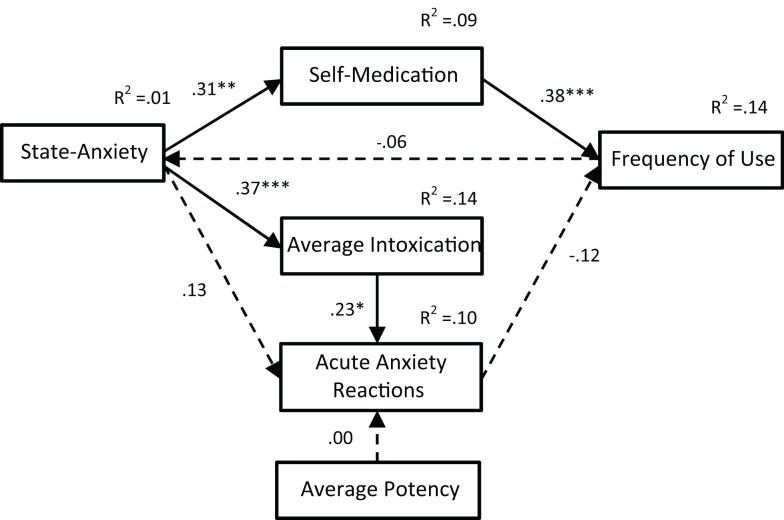
Path analysis of Model 1. With the exception of noted R2 values, all values are standardized regression weights (β), dashed lines indicate non-significant associations. Model fit: χ2(7) = 11.12, p = 0.133; TLI = 0.804; CFI = 0.909; RMSEA = 0.079 (0.000, 0.162). *p < 0.05, **p < 0.01, ***p < 0.001.